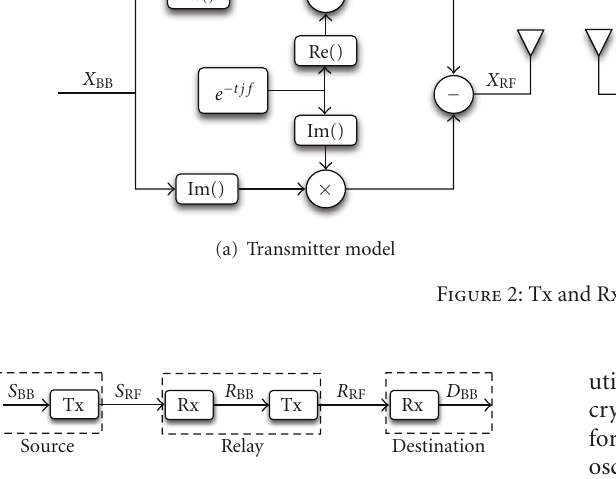
Figure 3: Nodes and signals in an amplify and forward link.